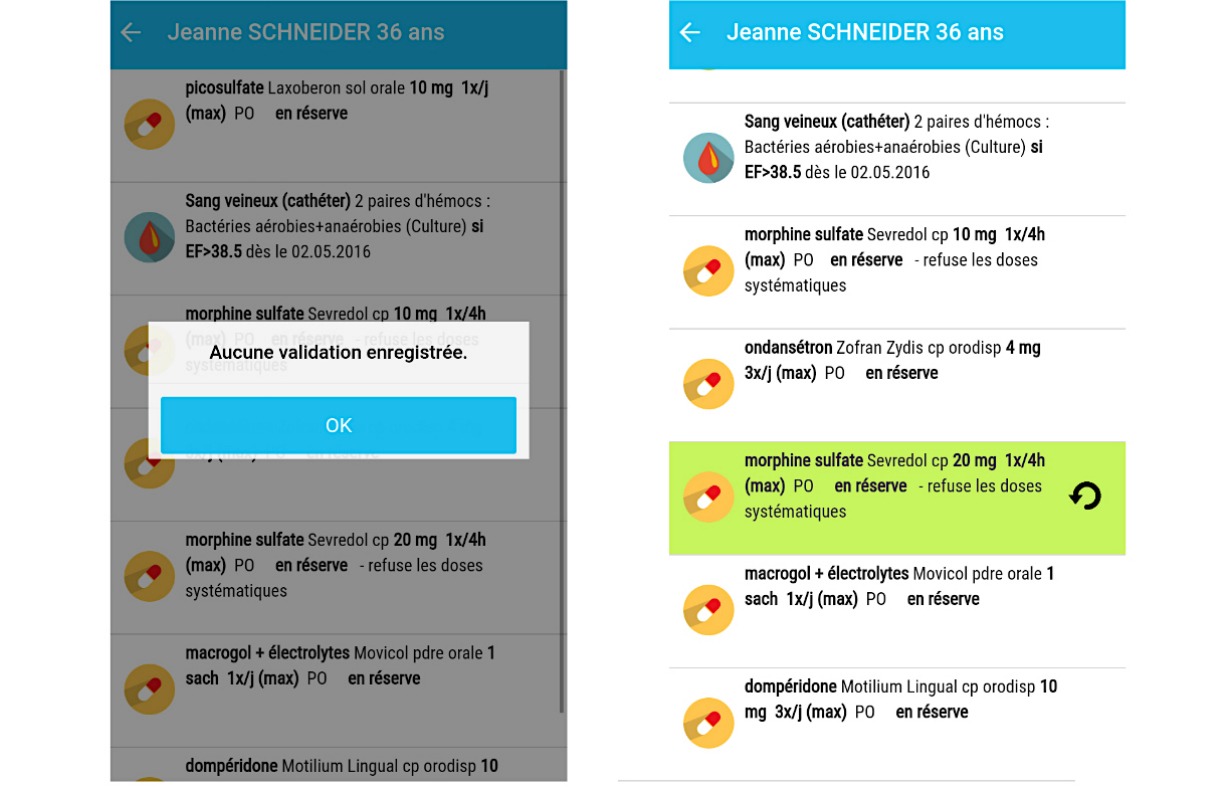
Figure 5. Problem with administration/validation of drugs from reserve.